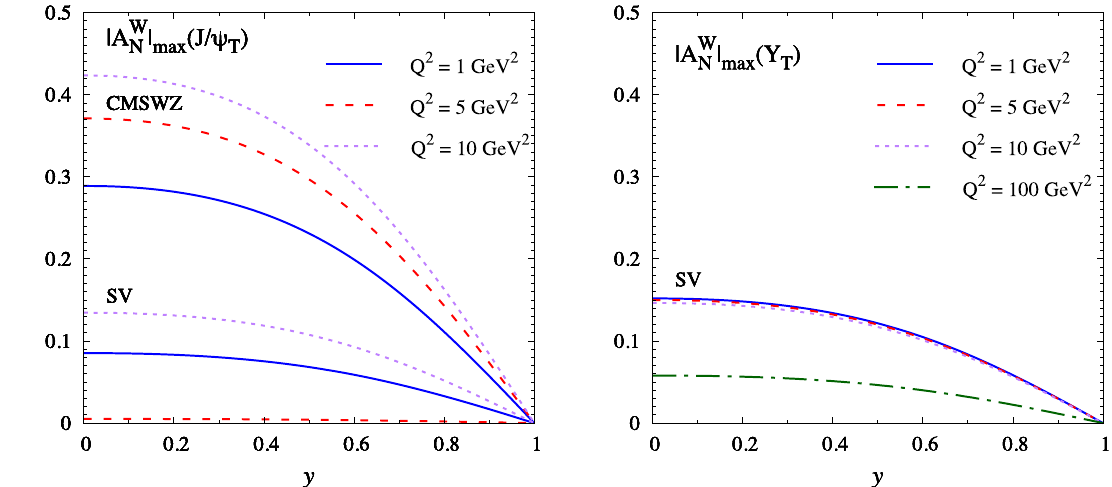
Fig. 5 Same as in Fig. 4, but for transversely polarized J /ψ (left panel) and ϒ (right panel) mesons